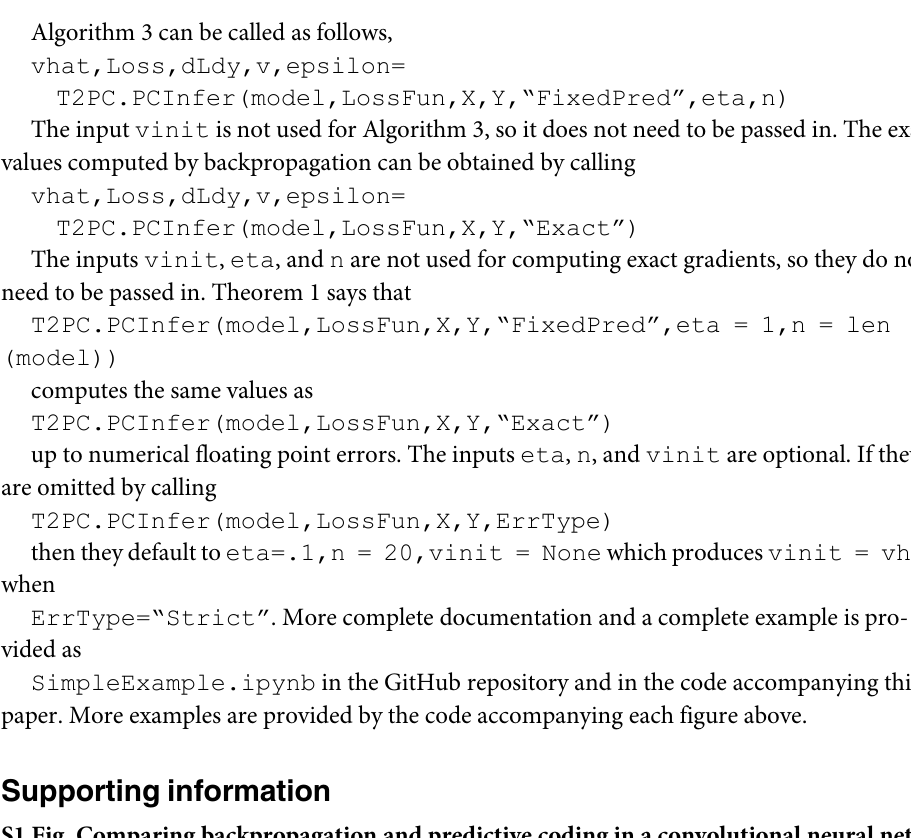
S1 Fig. Comparing backpropagation and predictive coding in a convolutional neural net- work trained on MNIST across multiple trials. Same as Fig 1 except the model was trained 30 times with different random seeds. Dark curves show the mean values and shaded regions show ± one standard deviation across trials. S2 Fig. Comparing backpropagation and predictive coding modified by the fixed predic- tion assumption in a convolutional neural network trained on MNIST across multiple trials. Same as Fig 3 except the model was trained 30 times with different random seeds. Dark curves show the mean values and shaded regions show ± one standard deviation across